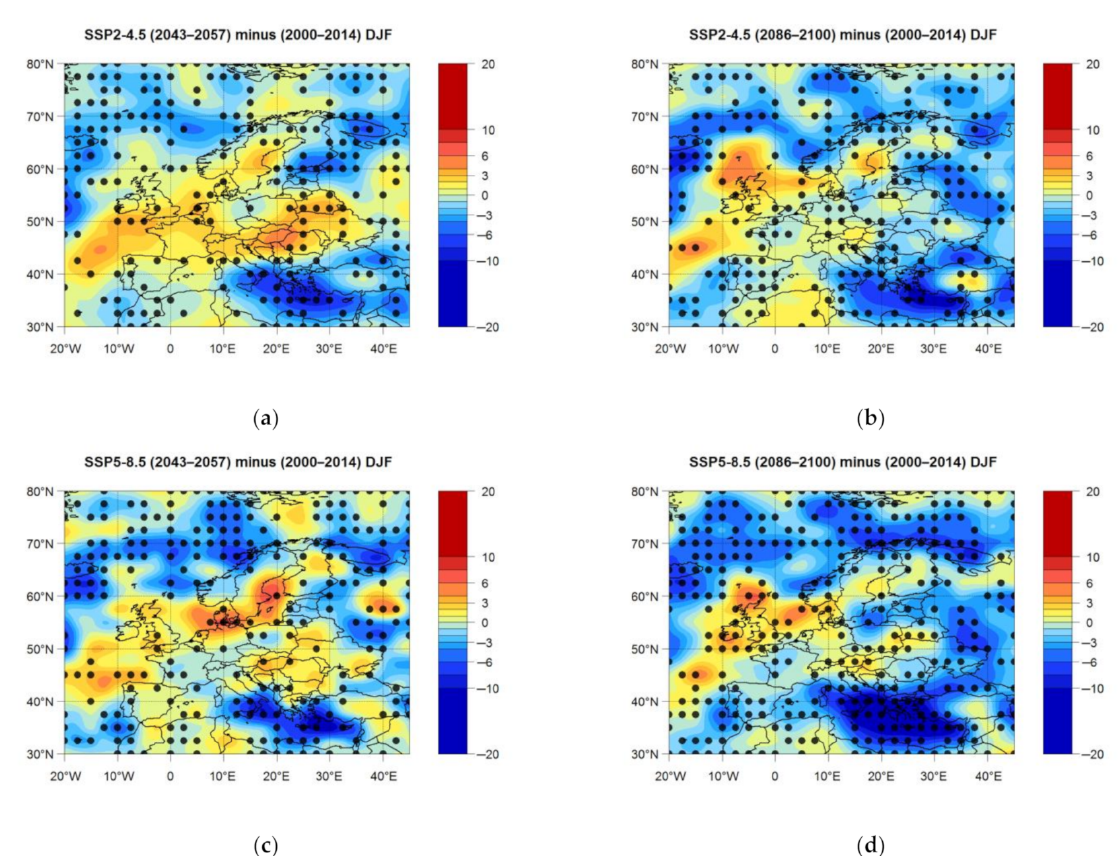
Figure 5. Absolute anomalies of the frequency of winter cyclones (difference in totals for 15 seasons) relative to the recent historical period (from 2000 to 2014) of the beginning of the century: ( a , c ) at the middle of the 21st century; ( b , d ) at the end of the 21st century; ( a , b ) under the SSP2-4.5 scenario; and ( c , d ) under the SSP5-8.5 scenario. Stippling indicates where 70% of the models agree on the sign of